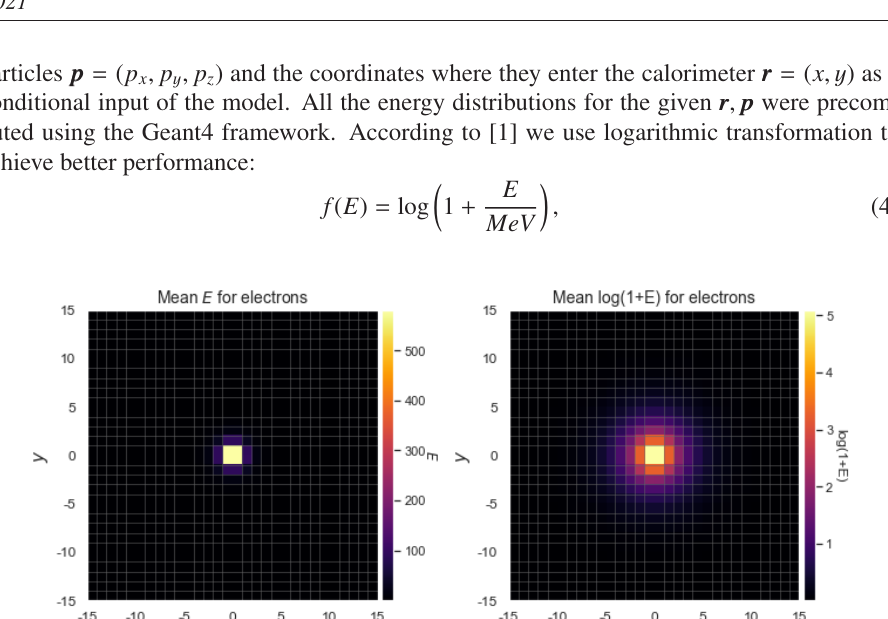
Figure 2: SAGAN architecture.